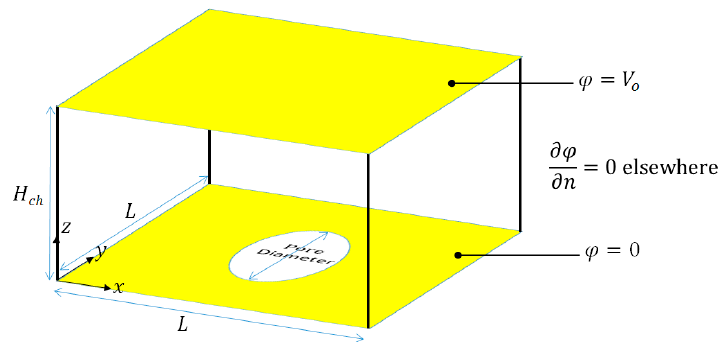
Figure 2. Schematic diagram of the repeating unit showing the boundary conditions and dimensions. The electrodes are shown in yellow.